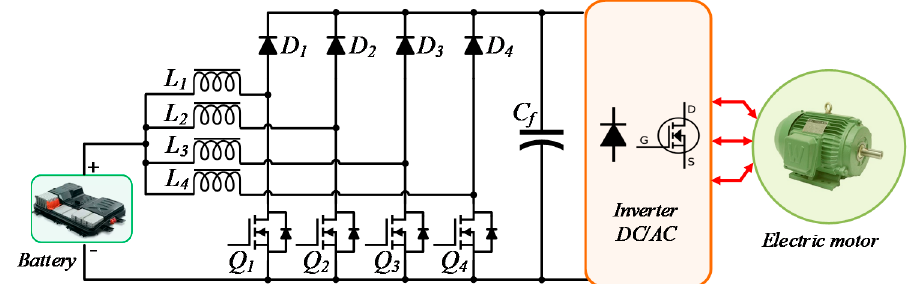
Figure 7. Interleaved 4-Phase DC-DC Boost converter.